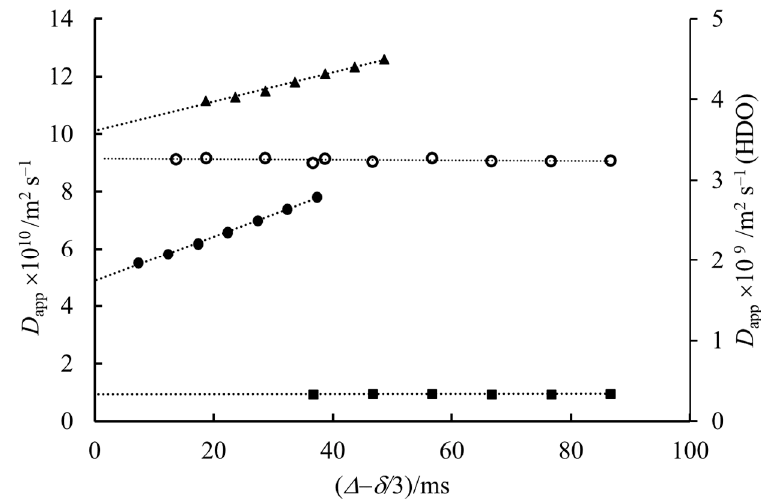
Figure 4. The dependence of the apparent diffusion coefficient of molecules present on the diffusion time at 319 K. ■ NaHDS ● NaDS and ▲ NaOS while ○ HDO.